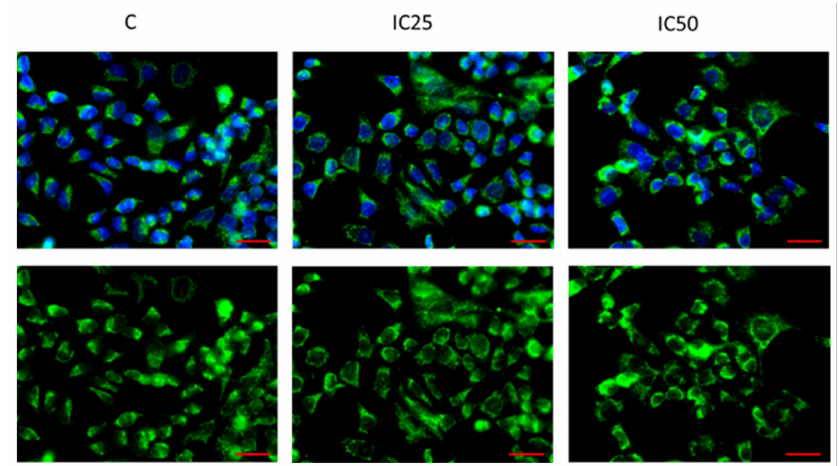
Figure 10. Immunofluorescence visualization of TGFBI expression in TOP-resistant cell line after piperine treatment. TGFBI was detected using the anti-TGFBI antibody and an Alexa Fluor ® 488- conjugated secondary antibody (green). Cell nuclei were stained with DAPI (blue). Column C shows the control state (cells without piperine); IC25 and IC50 show the cells treated with piperine for 72 h. The first row shows both DAPI (blue) and target protein signal (green), the second row shows the target protein signal alone. Scale bar = 2- µ m.